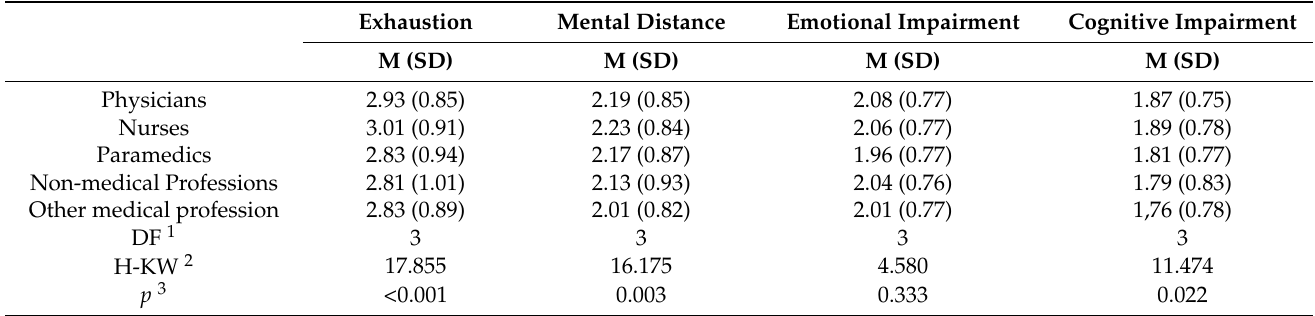
Table 4. Mean occupational burnout profile scores by profession (N = 2196).